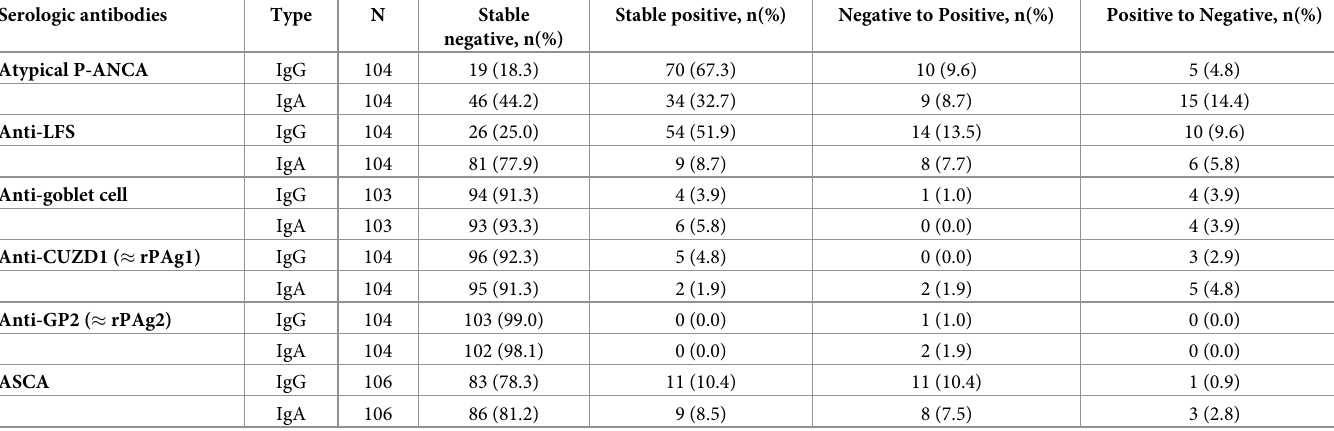
Table 3. Stability of serologic marker status over time in patients with ulcerative colitis (UC) during the disease